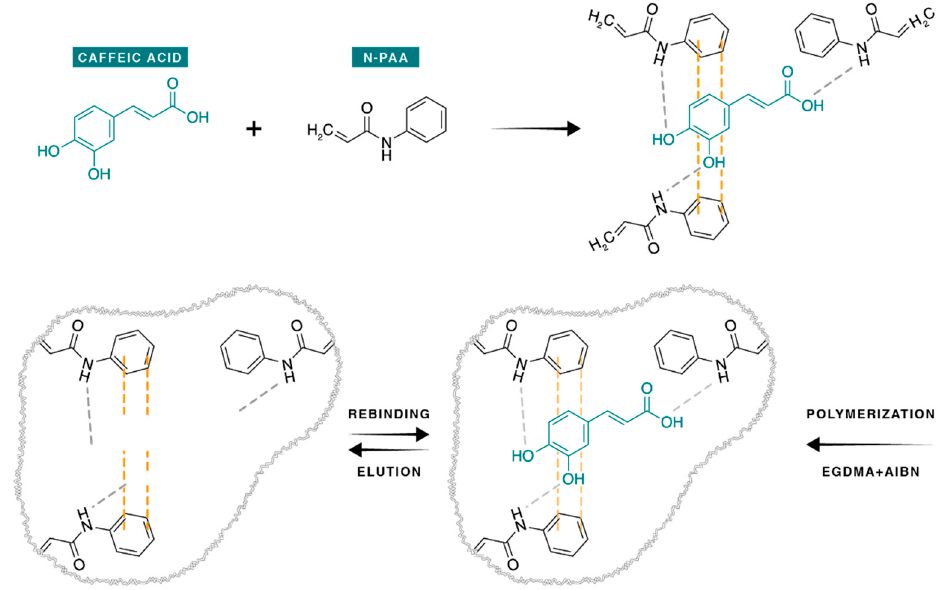
Figure 1. Proposed chemical reactions and interactions involved in the CA-MIP synthesis.